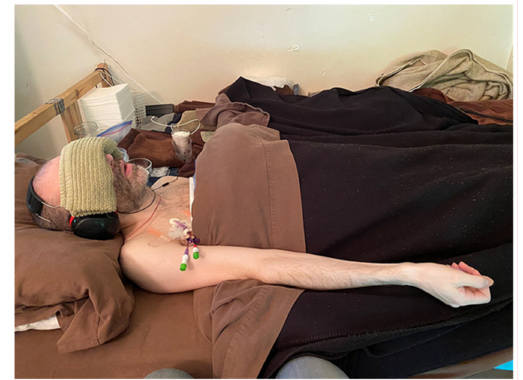
Figure 5. Isolating Myself from Caretaker